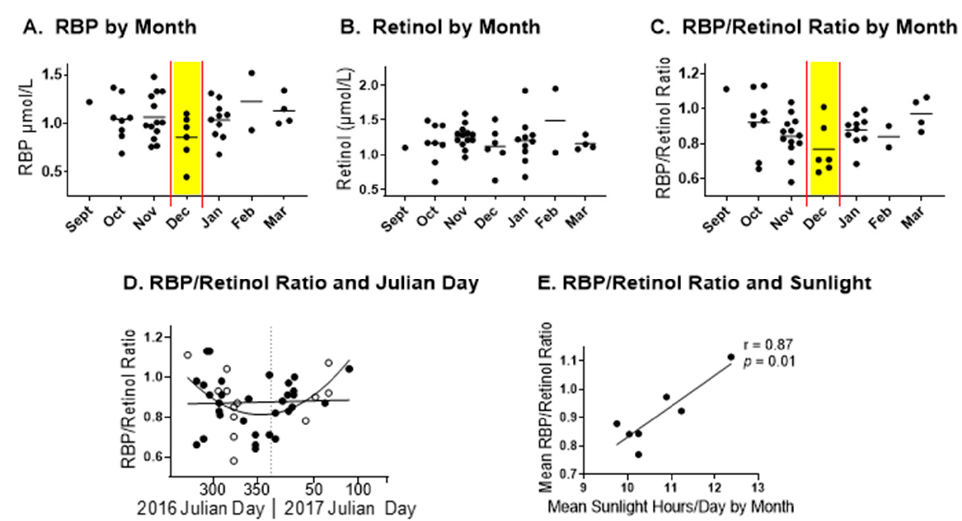
Figure 2. Seasonal changes in retinol/RBP ratios. ( A ) Individual RBP values ( µ mol/L) and means are shown per month of study enrollment. The month with the lowest mean value is highlighted in yellow. ( B ) Individual retinol values ( µ mol/L) and means are shown per month of study enrollment. ( C ) RBP/retinol molar ratios and means are shown per month. The month with the lowest mean ratio is highlighted in yellow. ( D ) RBP:retinol molar ratios were correlated with Julian days of the year. A linear regression line and a quadratic regression curve are shown (R 2 = 0.001, p = 0.81 for the linear regression; R 2 = 0.20 for the quadratic regression). Solid and open symbols represent black and white participants, respectively. Each symbol represents a different study participant for ( A – D ). ( E ) Mean RBP:retinol molar ratios were correlated with mean sunlight hours per day as measured in Nashville, Tennessee, each month (Pearson correlation).